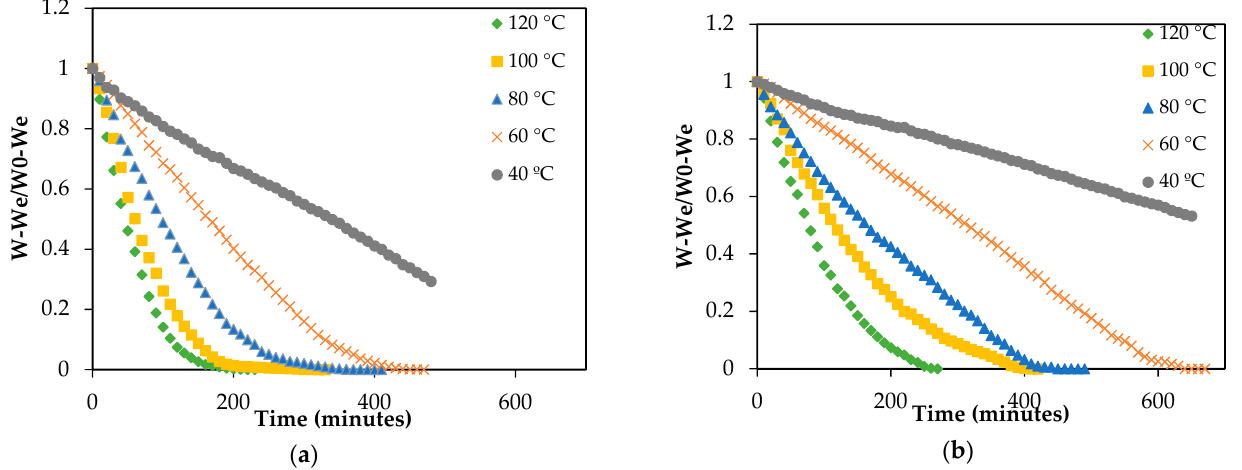
Figure 1. Evolution of the dimensionless moisture content during drying of artichoke bracts ( a ) and stems ( b ) at different temperatures.